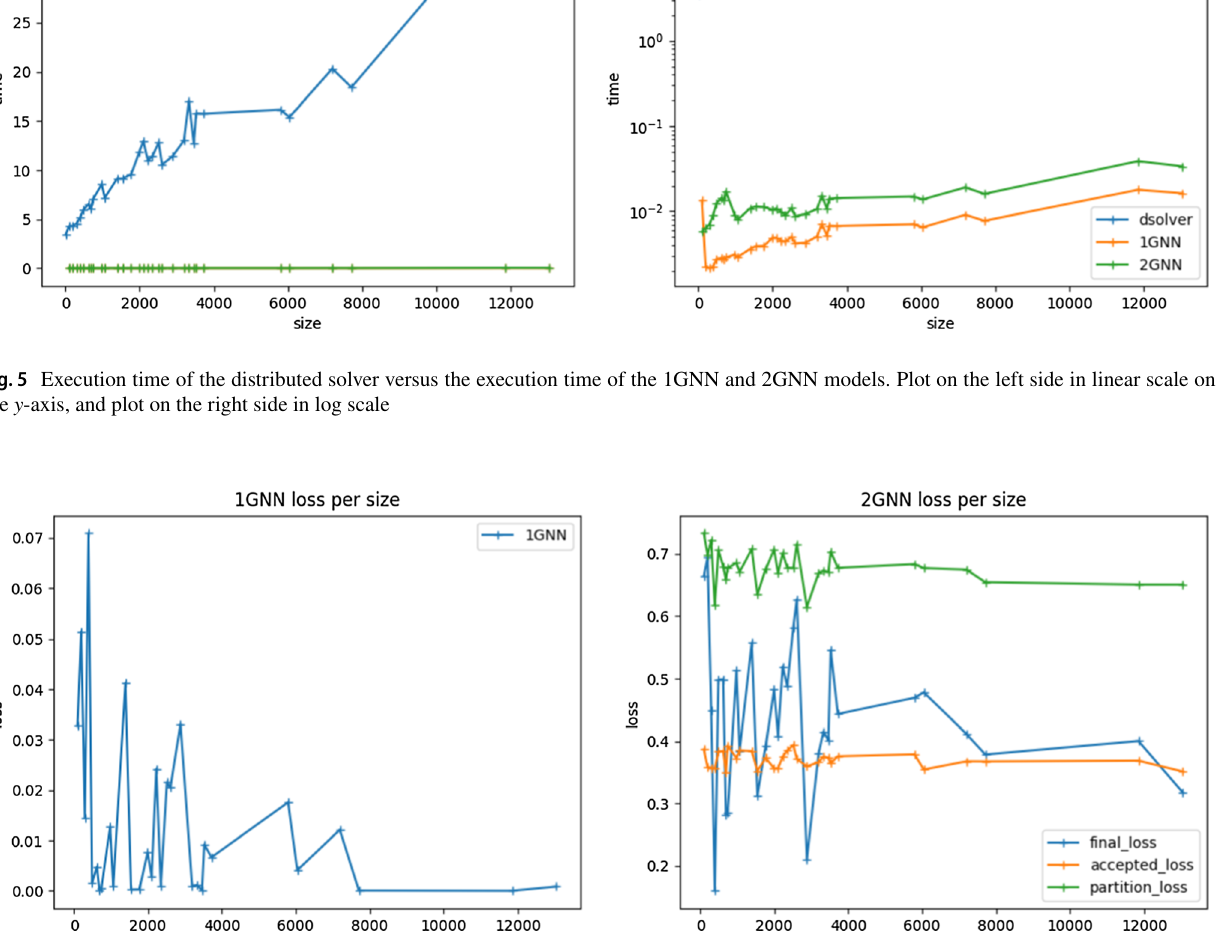
accepted comments (cf. Sect. 2). The partition loss is the logloss of the second GIN used to compute the bipartition of the corresponding WBDebG . The final loss is the MSE loss of the polarization compu-